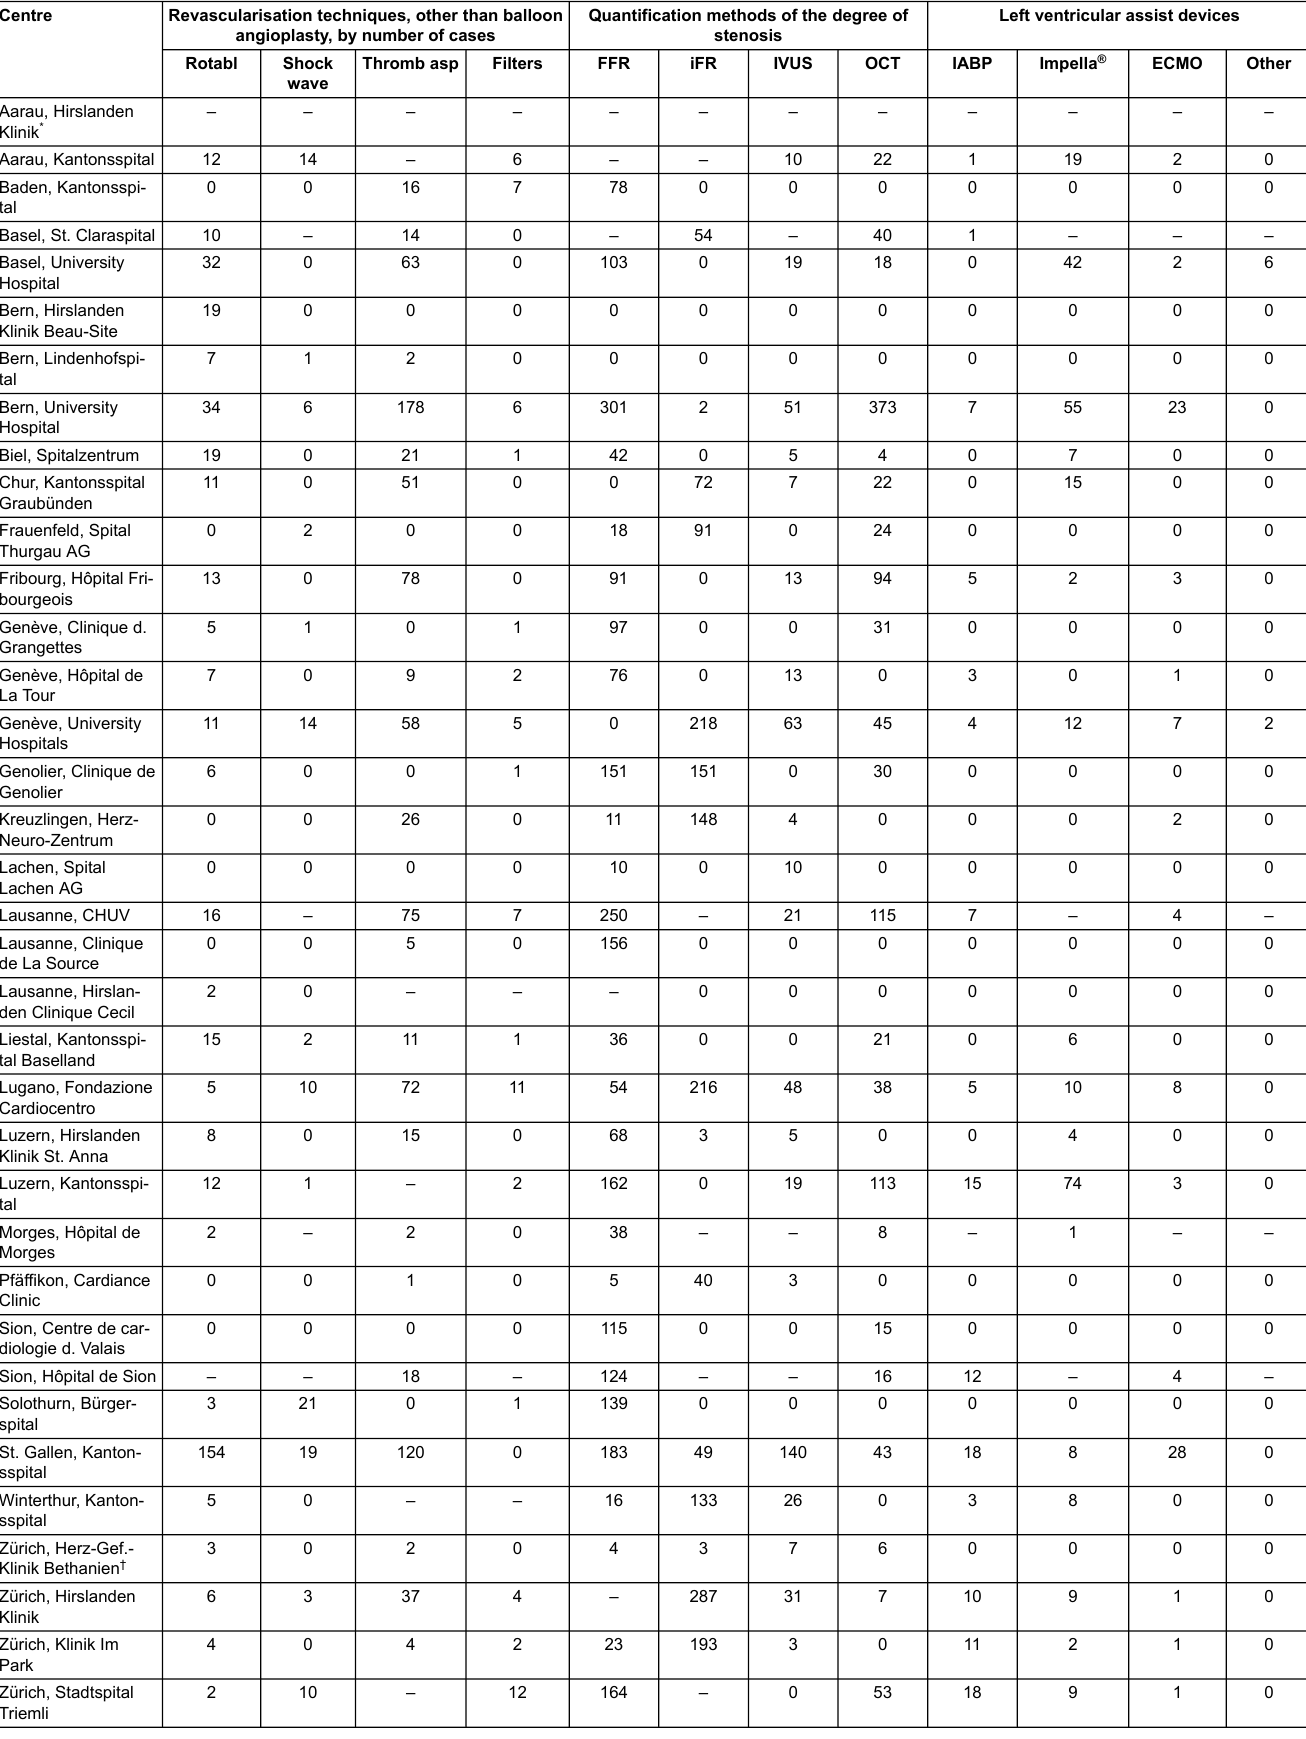
Table 5: Auxiliary coronary revascularisation techniques, quantification methods of coronary stenosis and left ventricular assist devices. Centre Revascularisation techniques, other than balloon Quantification methods of the degree of angioplasty, by number of cases